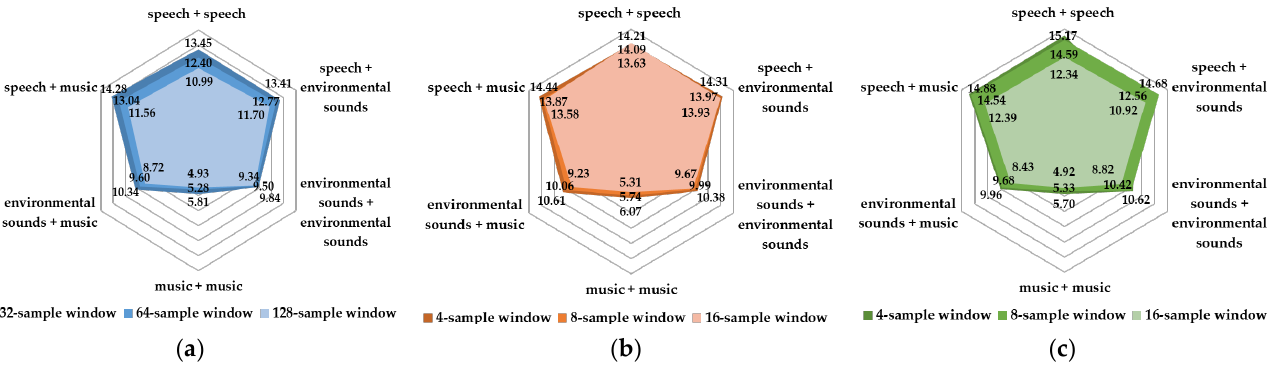
Figure 3. SI-SDR improvement (dB) of different types for mixtures in the test dataset for ( a ) ConvTasNet, ( b ) DPRNN, ( c ) DPTNet.